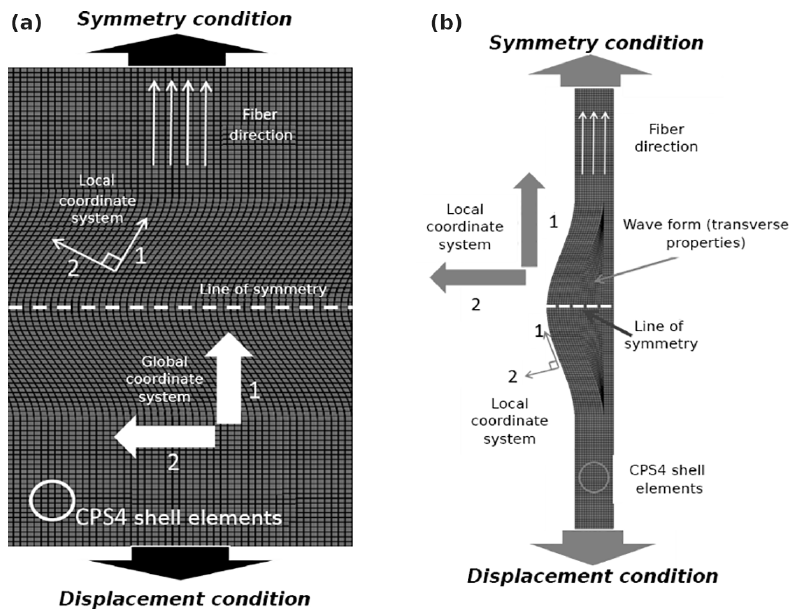
Figure 1. Representation of model and references used for the IP (a) and OP (b) wave